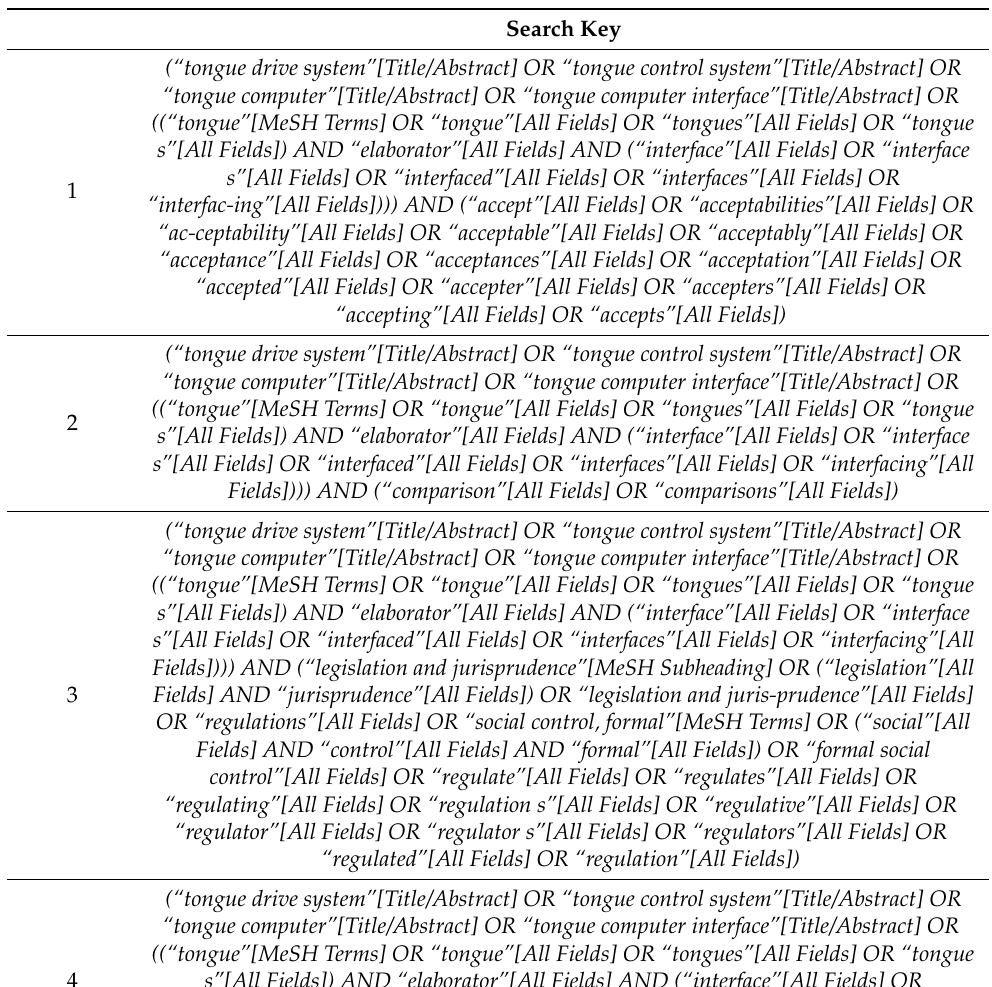
Table 4. The Search Keys in Section 3.4.